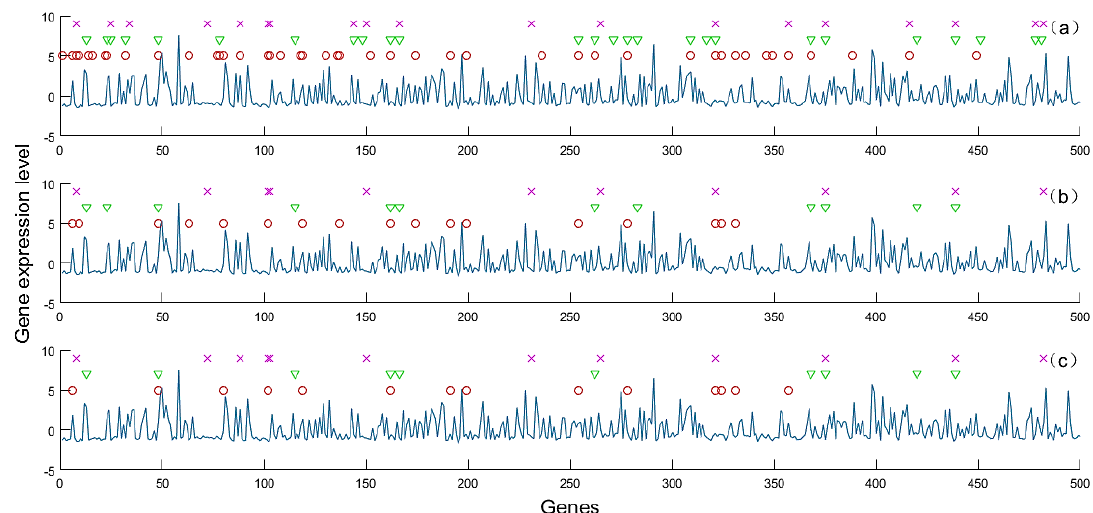
Figure 7. Feature selection results of proposed method with di ff erent α in one experiment for Dataset 11 (only the top 500 features are shown), where × , (cid:53) , indicate the selected class-specific features respectively, and – indicates the gene expression levels of one sample: ( a ) α = 0.1, the total number of selected feature is 477; ( b ) α = 0.5, the total number of selected feature is 272; ( c ) α = 0.9, the total number of selected feature is 253.